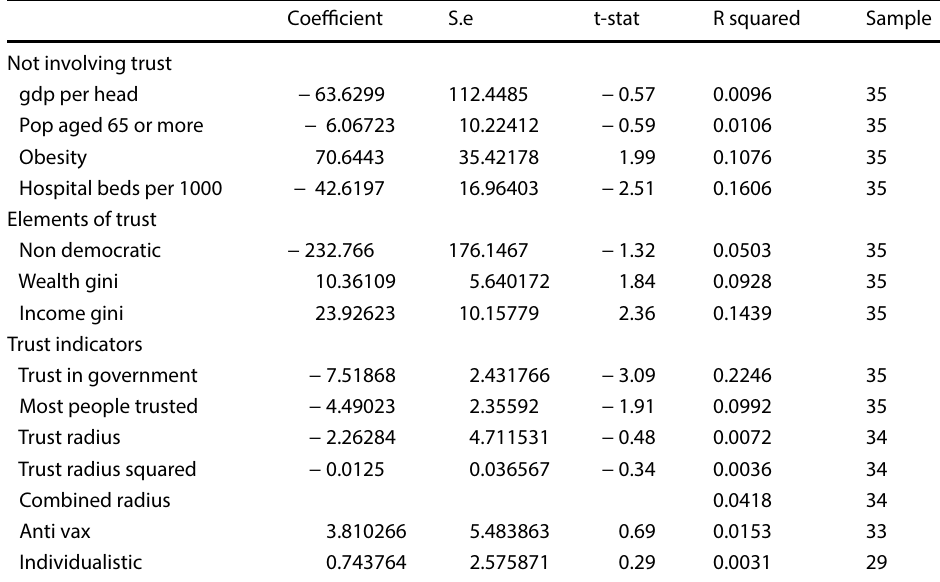
Table 1 Bivariate analysis— regressions on deaths for first